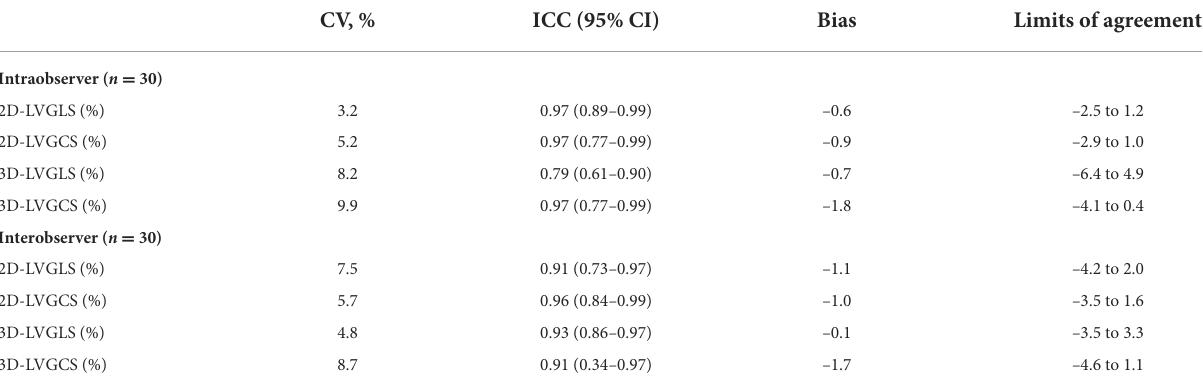
TABLE 5 Intraobserver and interobserver reproducibility for 2D- and 3D-STE parameters. CV,